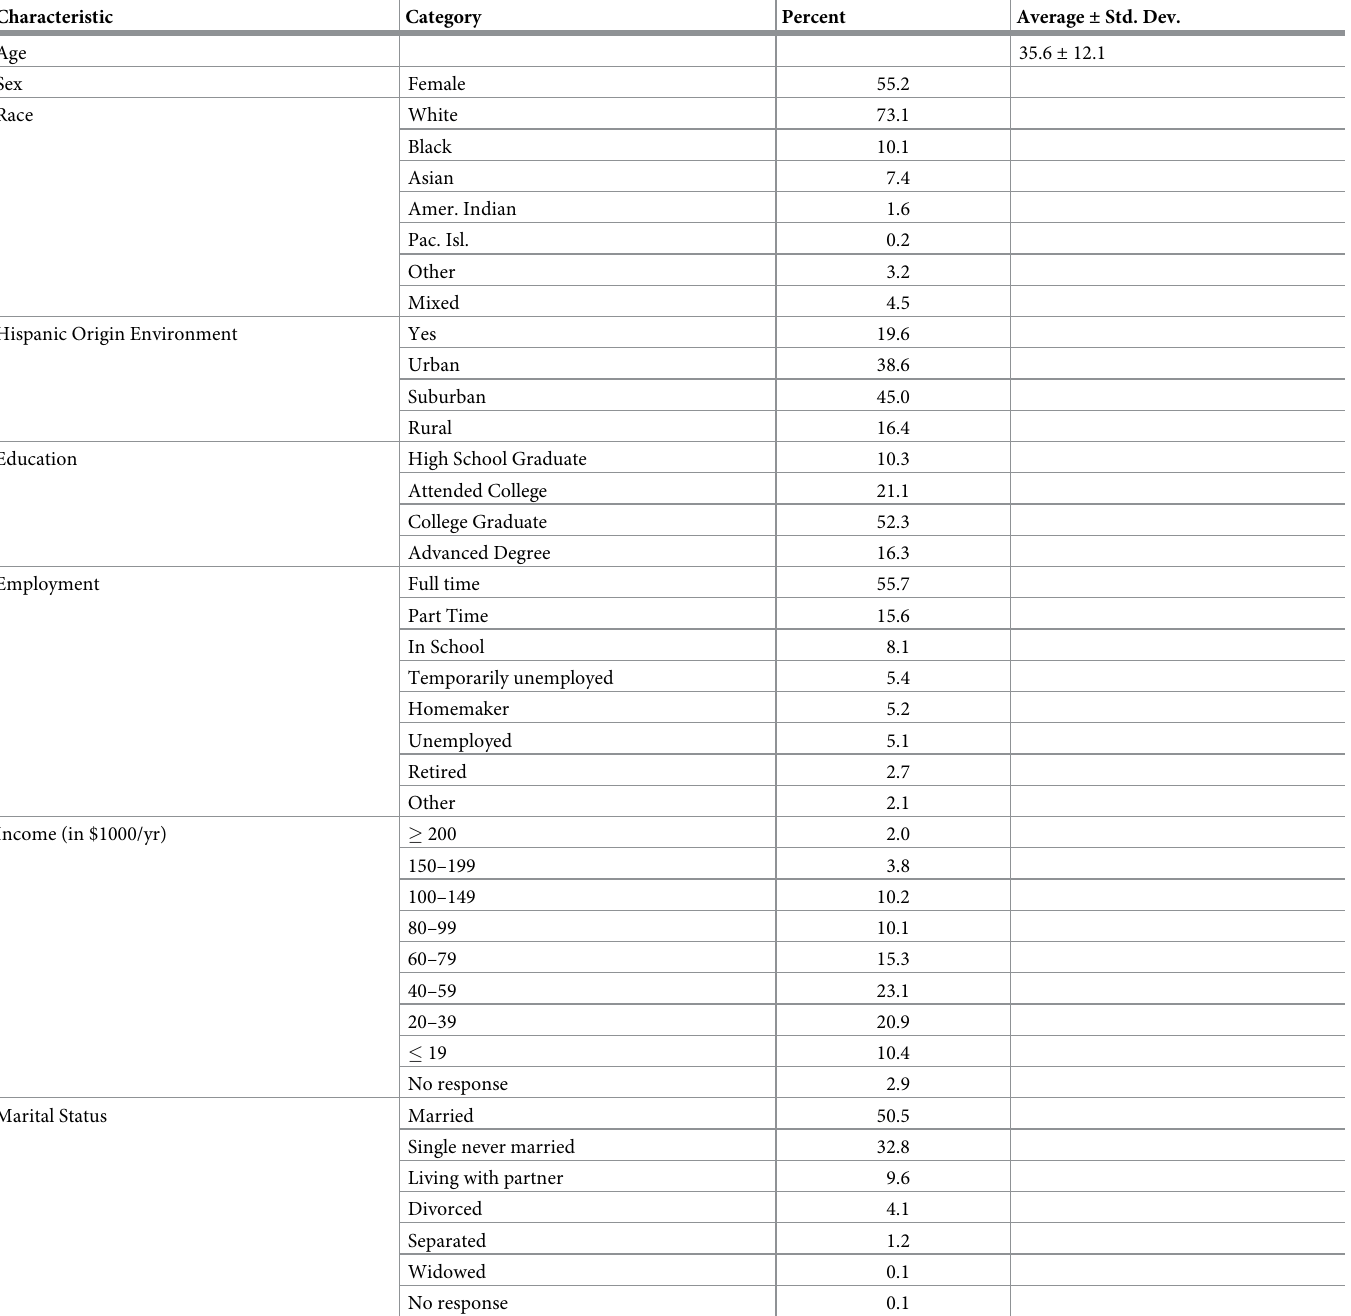
Table 3. Demographic characteristics of our experimental